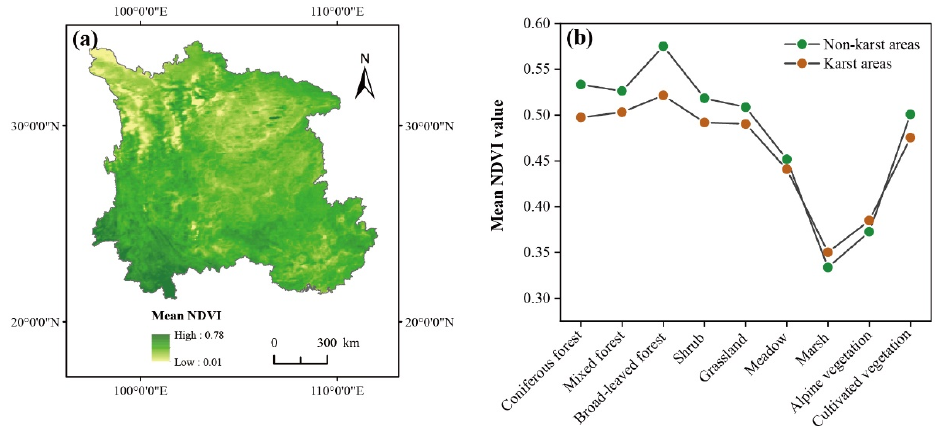
Figure 5. ( a ) Spatial distribution of interannual mean NDVI after reconstructing from 1990 to 2018; ( b ) interannual mean NDVI value of different vegetation types in karst and non-karst areas from 1990 to 2018.